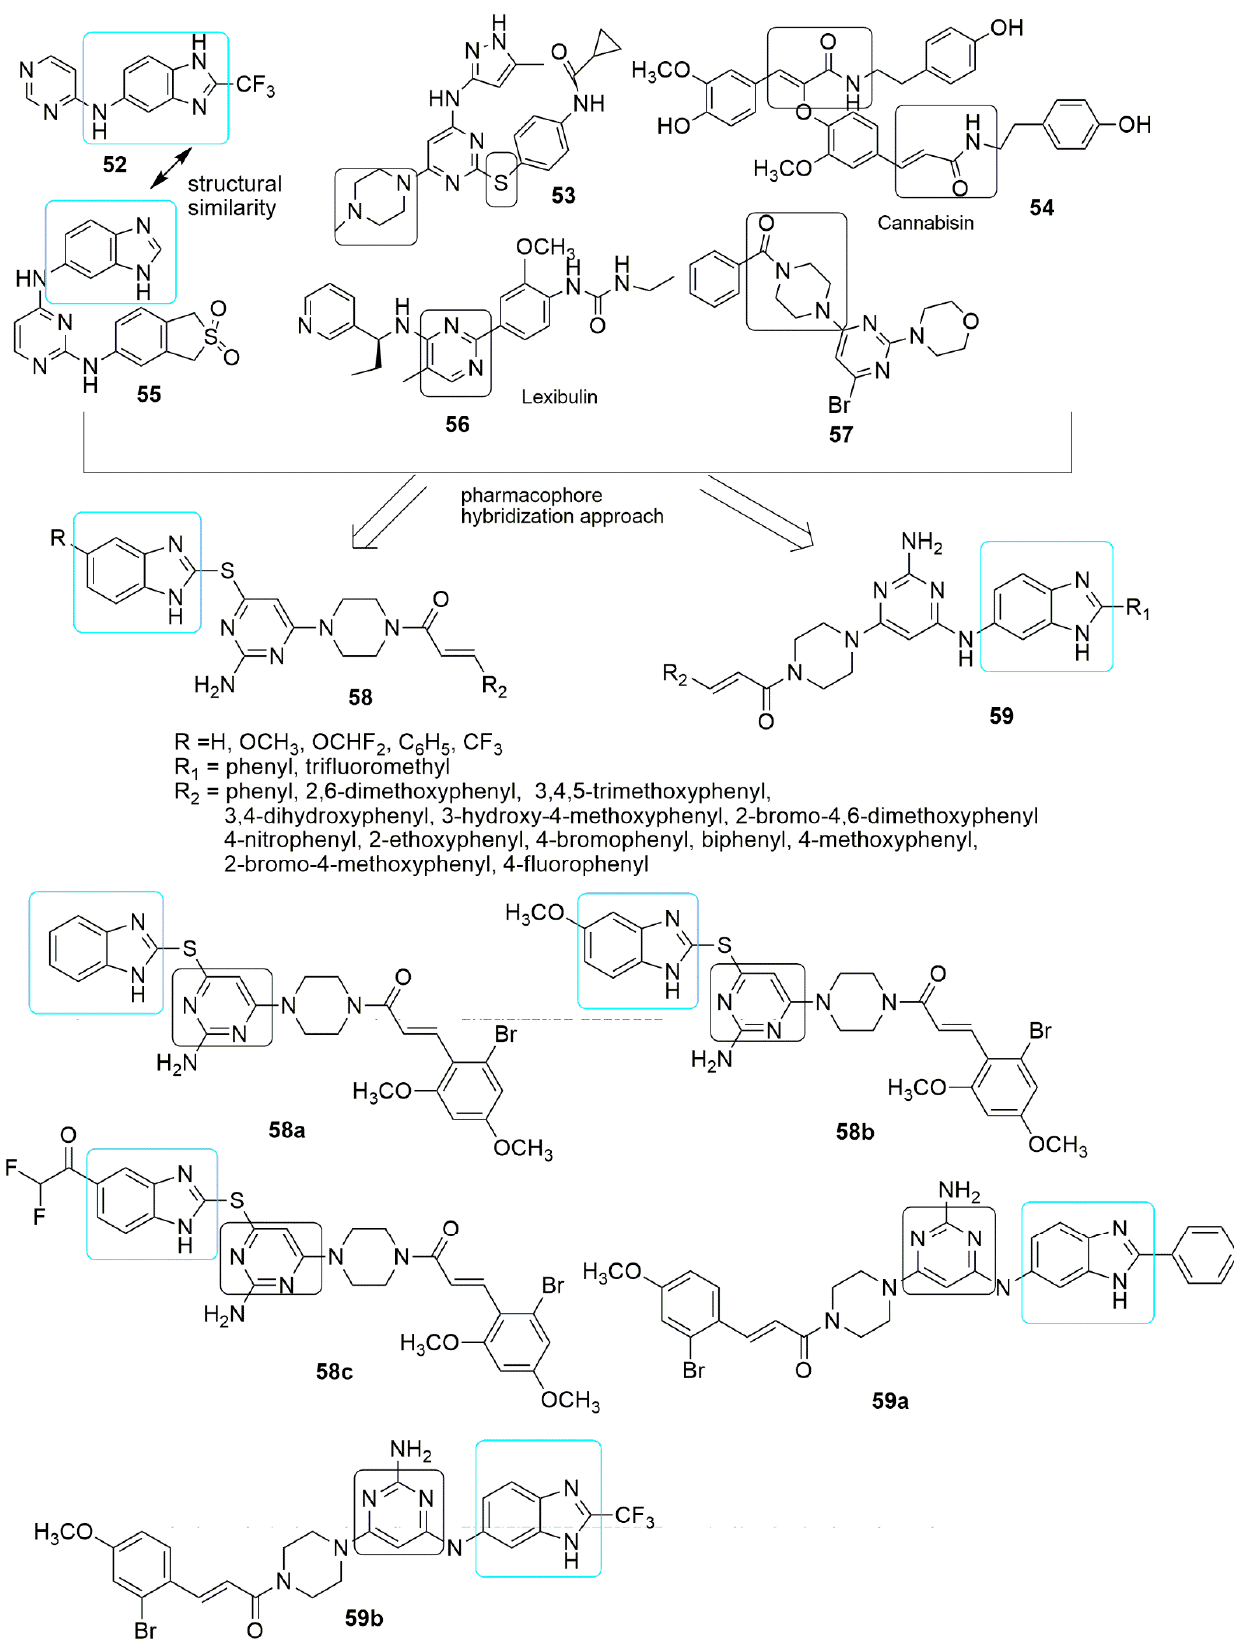
Figure 18. Pyrimidine-benzimidazole hybrids as anti-cancer